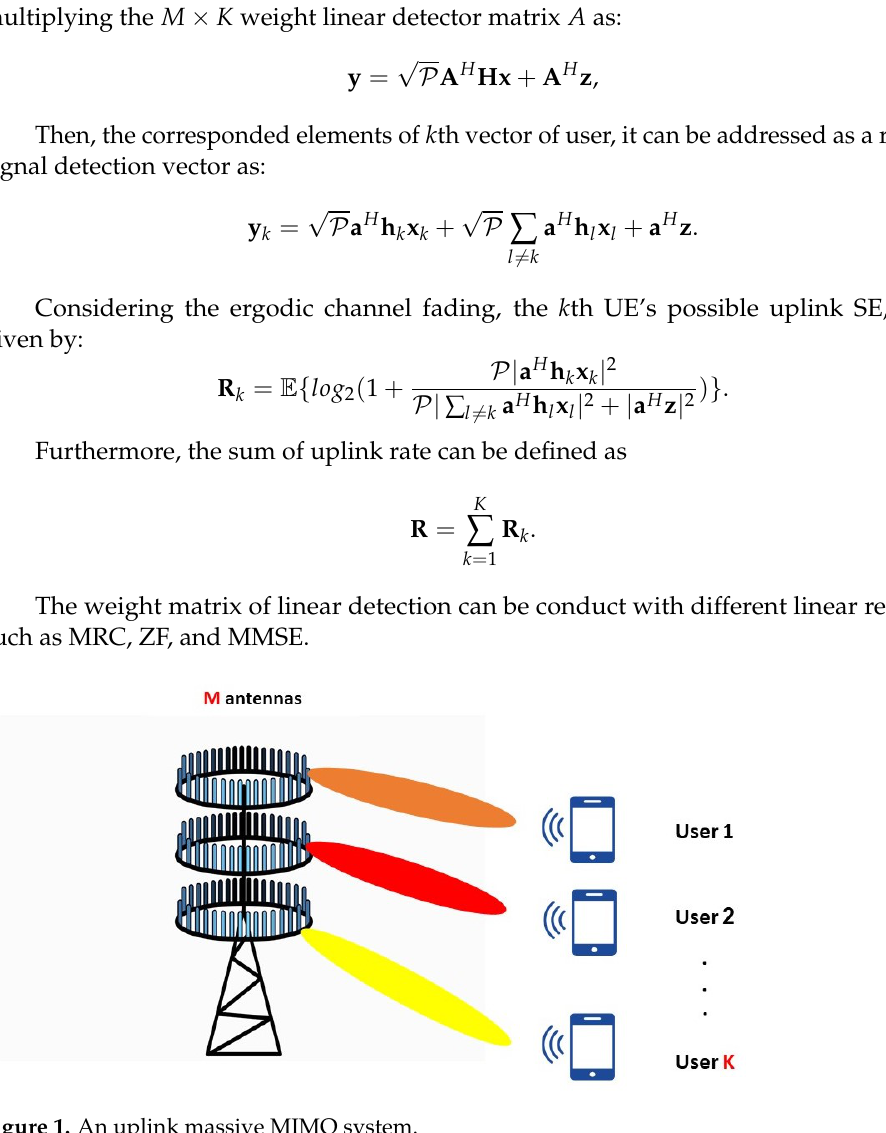
Figure 1. An uplink massive MIMO